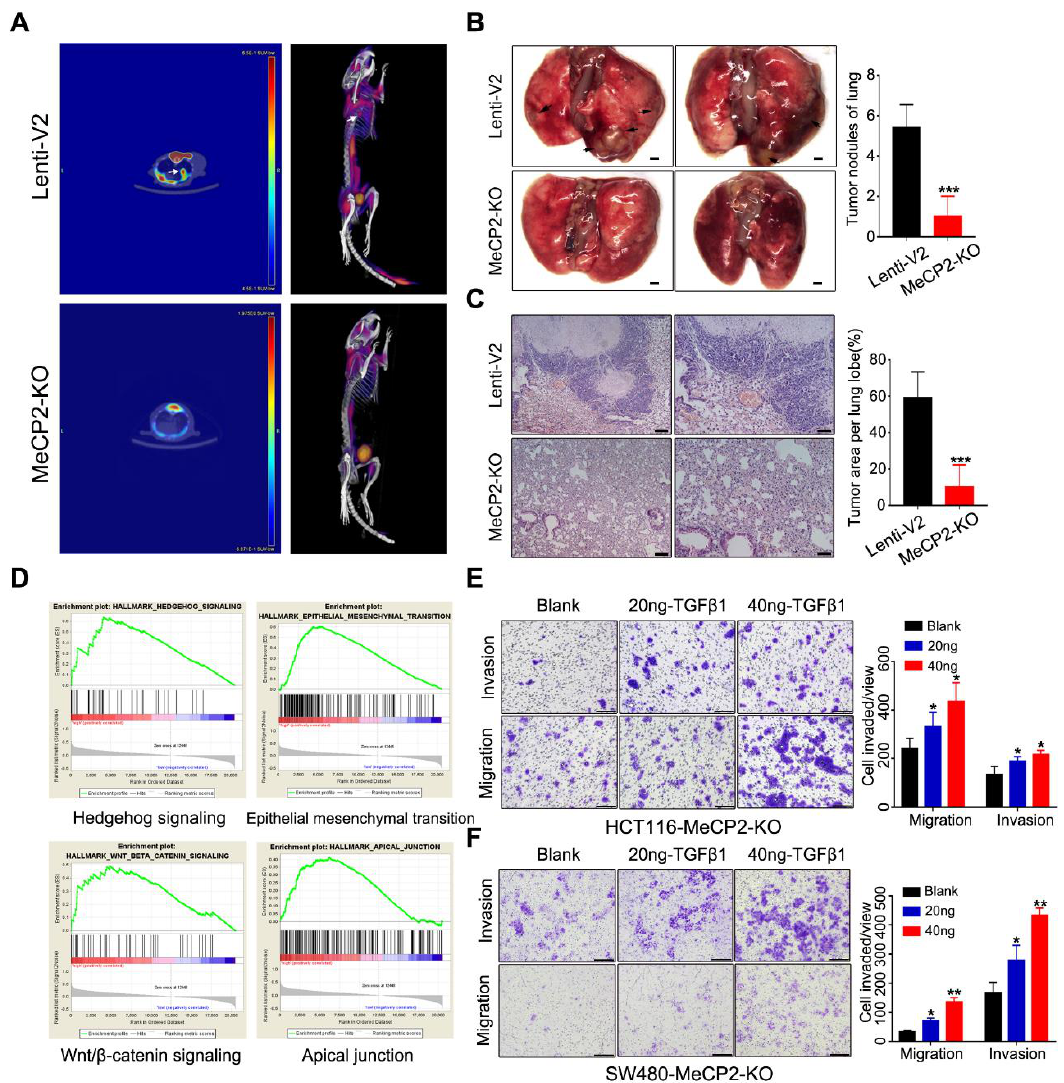
Figure 4. MeCP2 knockout suppresses metastasis in nude mice. ( A ) Comparison of representative transverse PET / CT images of 18 F-FDG in the tail vein injection of MeCP2-knockout or control HCT116 cells ( n = 6 mice per group). Arrow: metastatic lung nodules. ( B ) Pictures of metastatic lung nodules in nude mice. The arrows indicate the metastatic tumor on the surface of the lung (left). The number of nodules was quantified (right). ( C ) H&E staining was performed on serial sections of the lung tissue (left). The area containing nodules was quantified (right). ( D ) Representative Gene Set Enrichment Analysis (GSEA) plots enriched in the Cancer Genome Atlas (TCGA) colorectal cancer (CRC) group of high MeCP2 expression, with the significance defined by q < 0.25. ( E ) TGF- β 1 treatment abrogated the inhibition of the migration and invasion enforced by MeCP2-knockout in HCT116 cells. ( F ) TGF- β 1 treatment abrogated the inhibition of the migration and invasion enforced by MeCP2-knockout in SW480